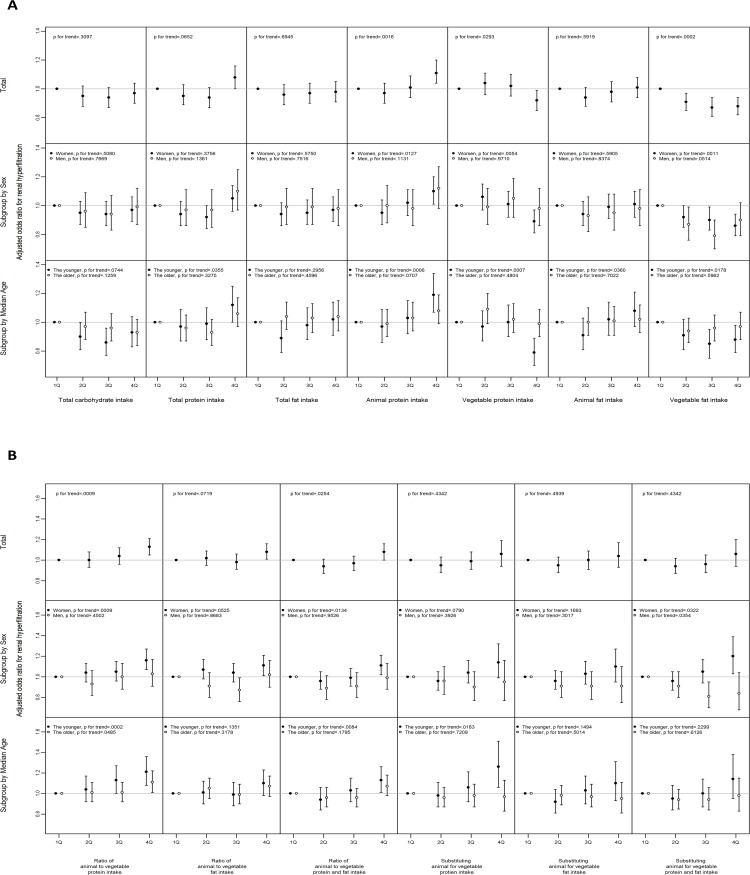
The association between renal hyperfiltration and the components of habitual dietary intake.(A) The level of total intake of carbohydrate, protein and its sources, and fat and its sources. (B) The ratio of animal to vegetable sources of protein and fat and the substitution model. All logistic regression analyses were adjusted for systolic blood pressure, alcohol intake, smoking status, regular exercise, fasting serum glucose, serum triglyceride, serum high density lipoprotein cholesterol, and albuminuria. The median age of men was 51 years and that of women was 50 years. Error bars mean 95% confidence interval. See Subjects and Methods for the definition of renal hyperfiltration.